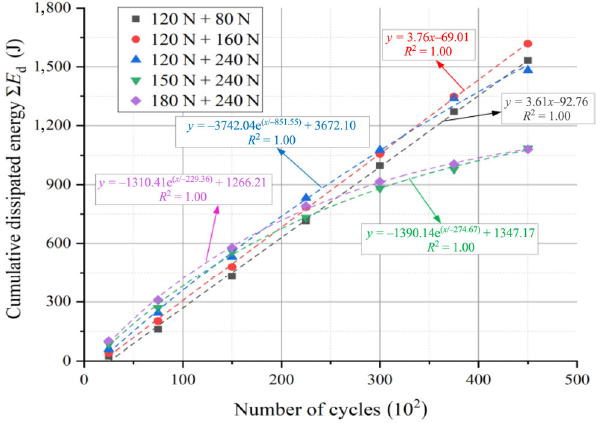
Fig. 15 Cumulative dissipated energy diagram under different loading conditions.